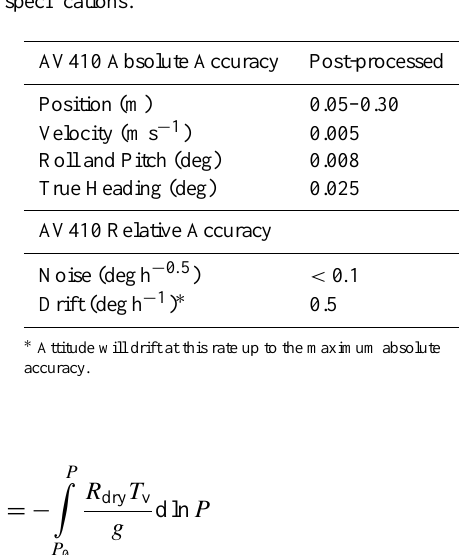
Fig. 9. Scatter plots of: (top panel) attack angle [deg] vs. vertical acceleration [m s − 2 ]; and (bottom panel) sideslip angle [deg] vs. lateral acceleration [m s − 2 ]. Table 1. Trimble/Applanix airborne positioning system perfor- mance